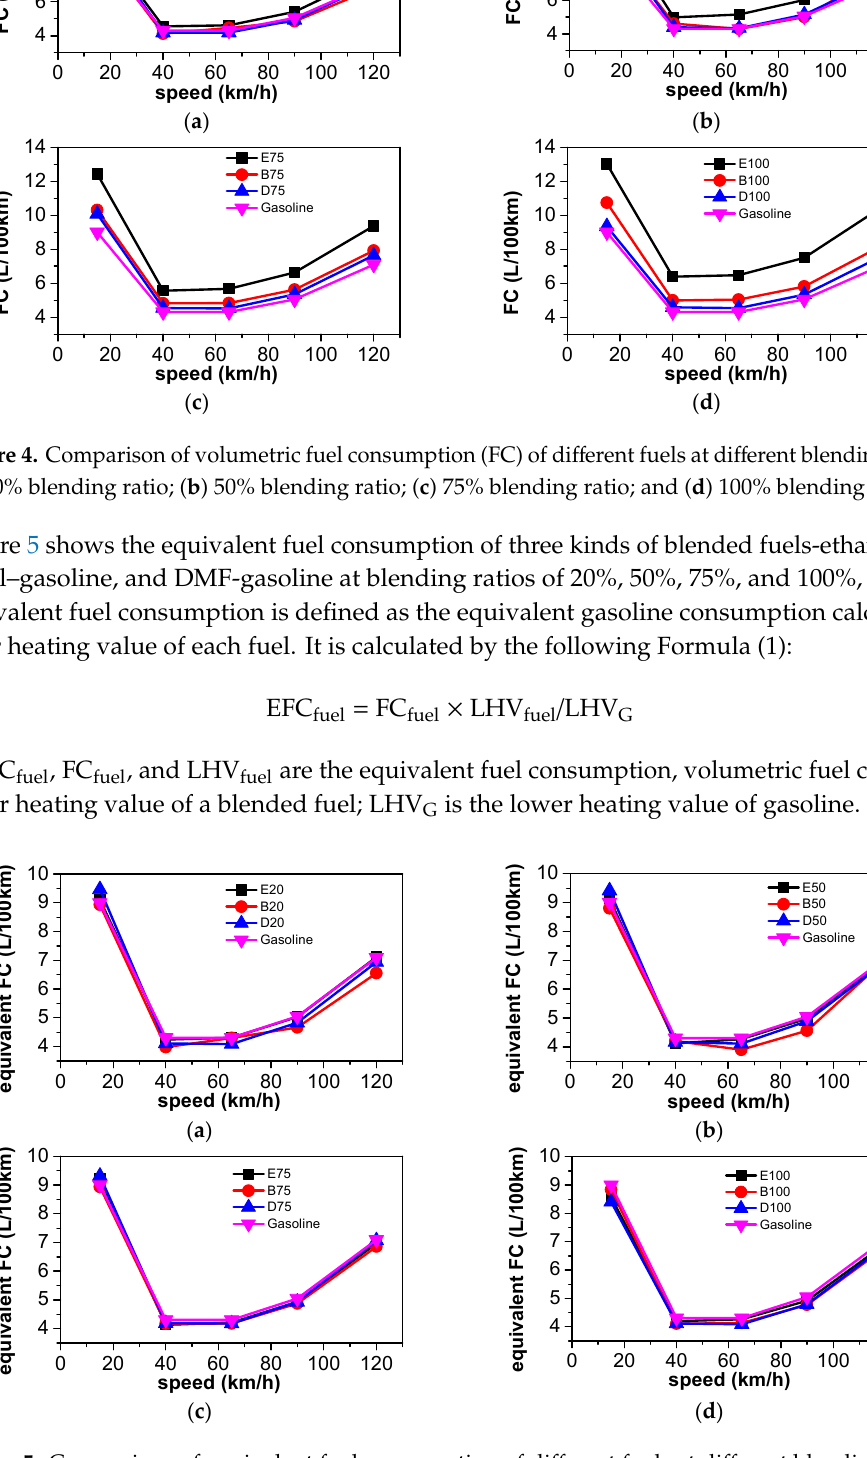
Figure 5. Comparison of equivalent fuel consumption of different fuels at different blending ratios: ( a ) 20% blending ratio; ( b ) 50% blending ratio; ( c ) 75% blending ratio; and ( d ) 100% blending ratio .